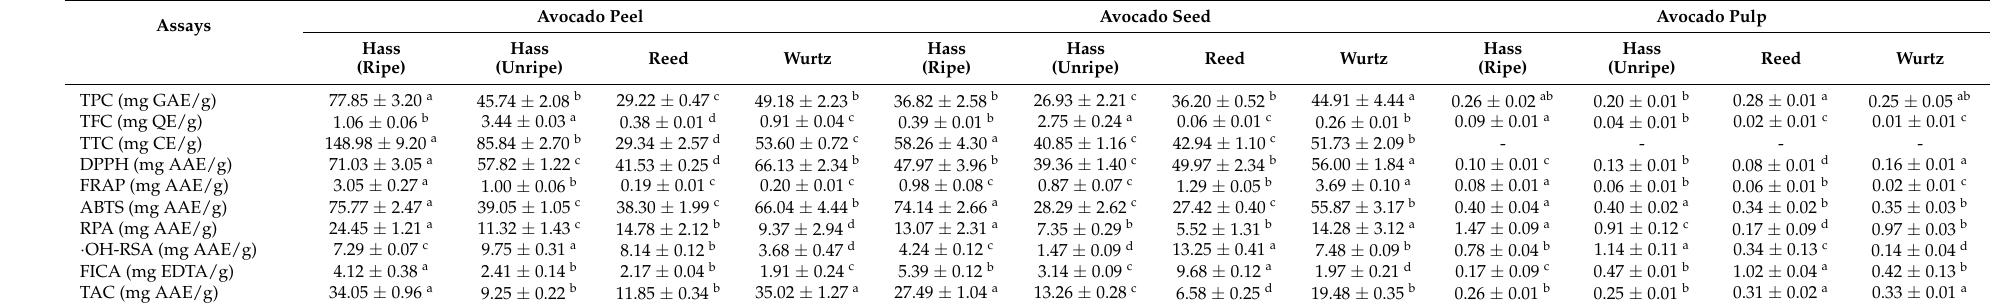
Table 1. Polyphenol content and antioxidant activity detected in different fresh avocado peels, seeds, and